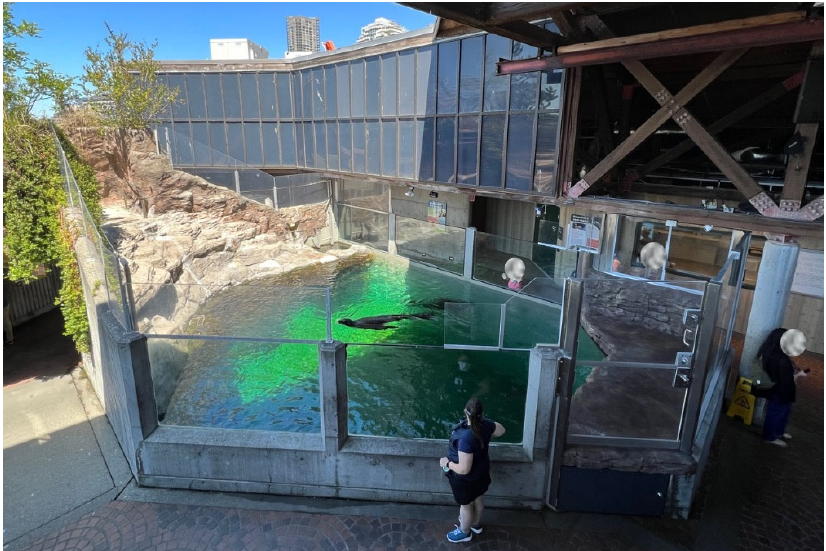
Figure 9. Photo shows an overlook of the Northern fur seal exhibit with one seal engaged in Surface Swimming and one seal engaged in Nonpatterned